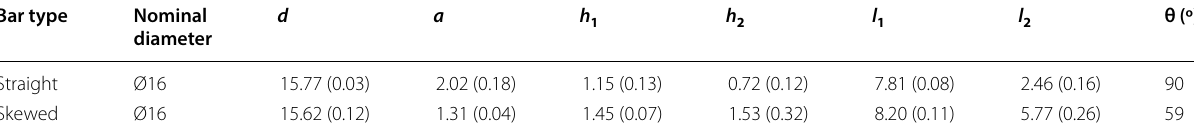
Average values and standard deviations (in brackets).